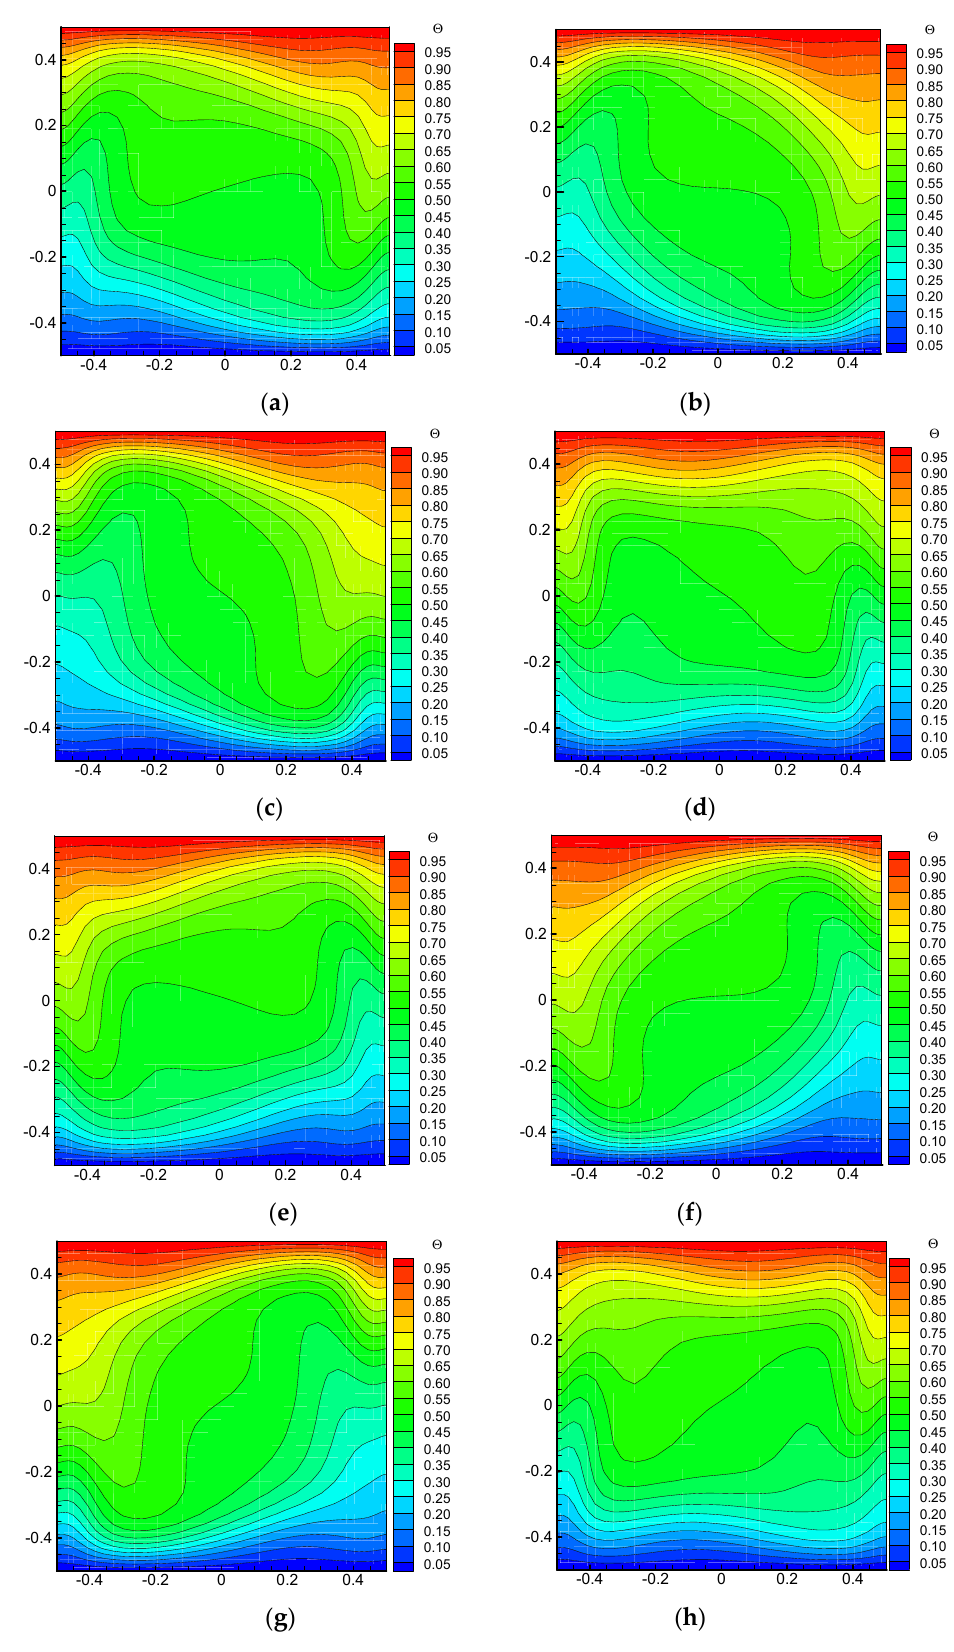
Figure 6. Temperature field evolution at x-o-y plane for Case 1: ( a ) ϕ = 0 (+) ; ( b ) ϕ = ϕ